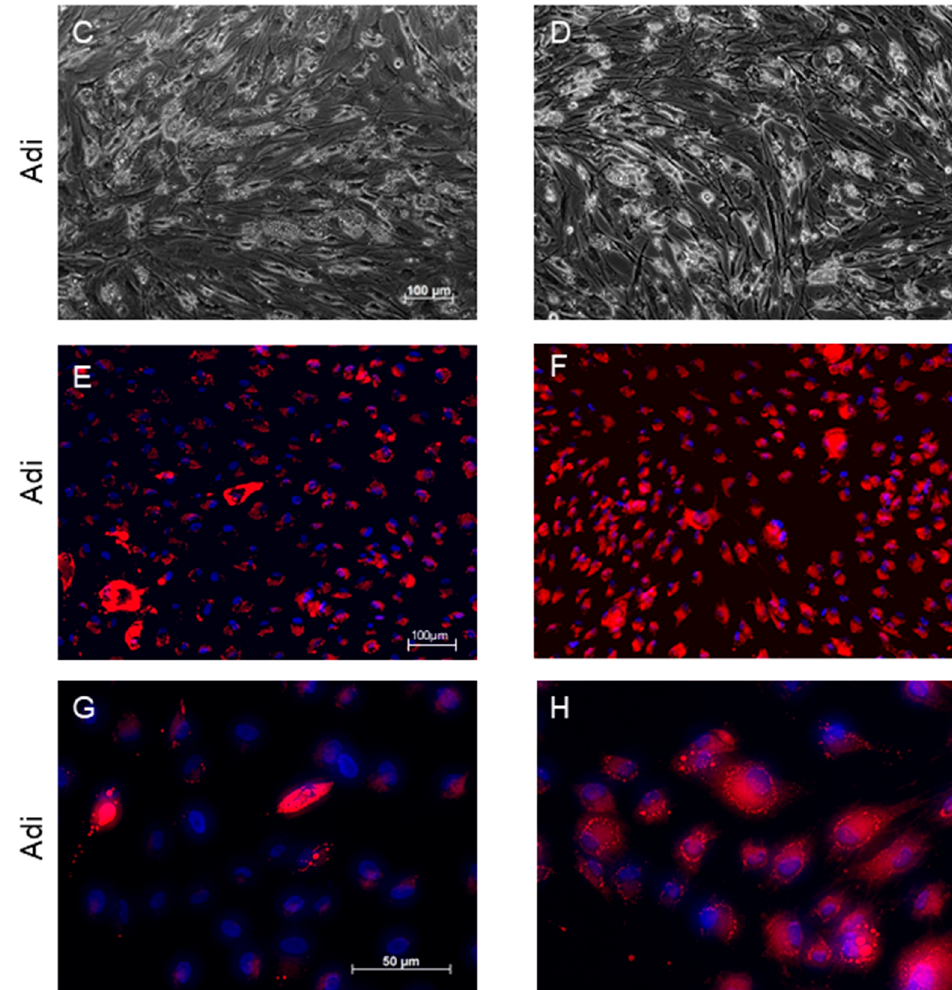
Figure 2. ASCs cultured on plastic or collagen I. ( A , B ) show the cell morphology after cultivation in ASC standard medium (ctr) for 19 days, ( C , D ) after cultivation in adipogenic medium (Adi). (E – H) display cellular lipids (red) after cultivation in adipogenic medium for 19 days stained with the fluorescence dye nile red; cell nuclei (blue) are stained with bisbenzimide. Photographs show nile red; cell nuclei (blue) are stained with bisbenzimide. Photographs show representative representative sections.